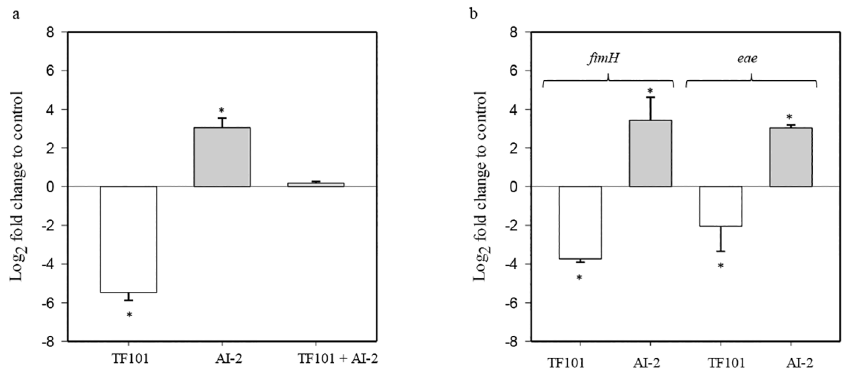
Fig 2. The effect of TF101 or AI-2 on expression of lsrB , fimH and eae in E . coli O103:H2. (a) TF101 significantly reduced expression of lsrB , while AI-2 gave a significant increase in expression of lsrB . TF101 and AI-2 added simultaneously attenuated the increase in lsrB expression following AI-2 stimulation (b) Expression of fimH and eae was significantly decreased following exposure to TF101, while AI-2 gave a significant increase in the expression of the same genes. (0 = control without exposure to TF101, AI-2 or both, respectively). The data are presented as mean values ± SD (n = 6). * Significantly different from control ( P < 0.05).